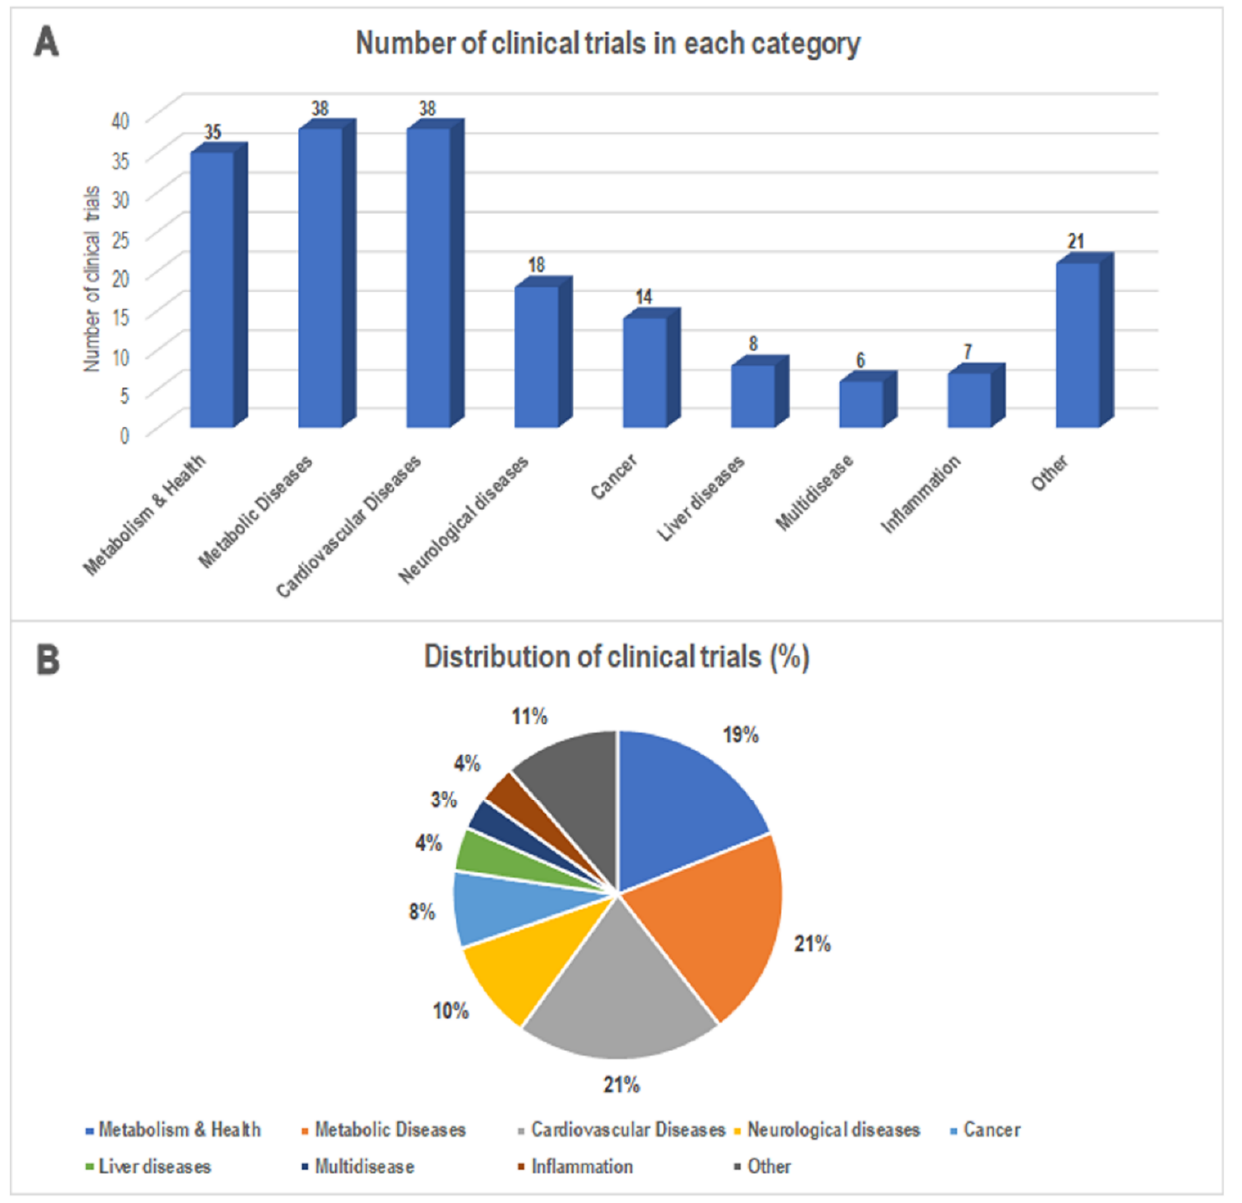
Figure 3. ( A ) The number and ( B ) percentage of MedDiet-based clinical trials classified according to the indications provided by the clinical trials database. Data from http://www.clinicaltrials.gov/ (accessed on 31 January 2022).